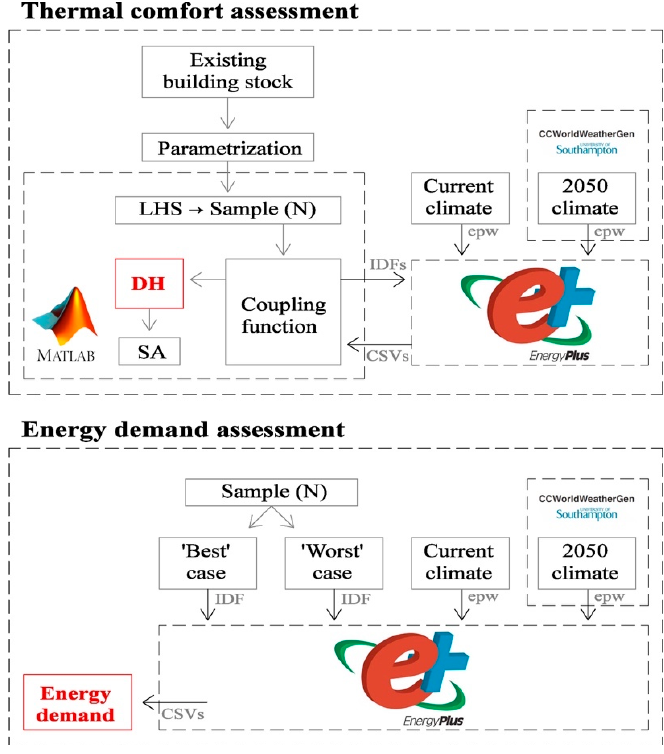
Figure 1. Methodology scheme.